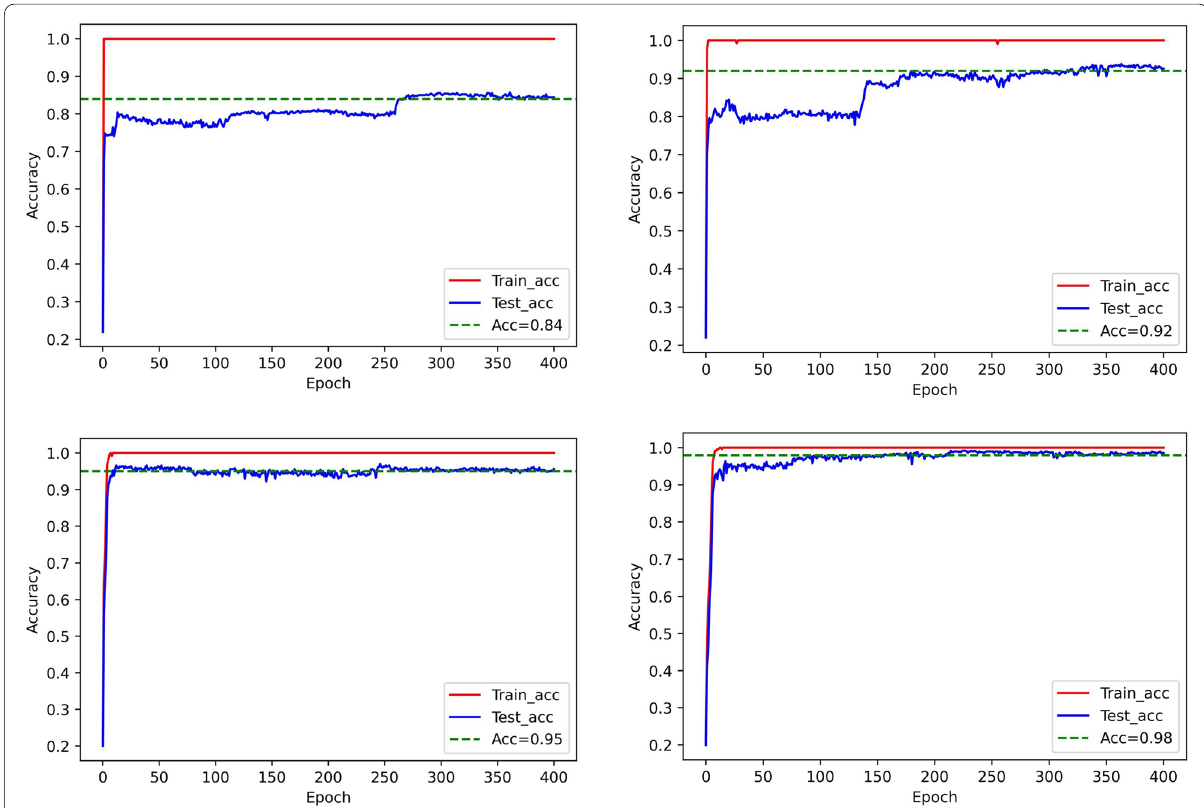
Fig. 8 Training and testing accuracy curves under different number of training samples. (Upper left) (a) Training Set A (Upper right) (b) Training Set B (Lower left) (c) Training Set C (Lower right) (d) Training Set